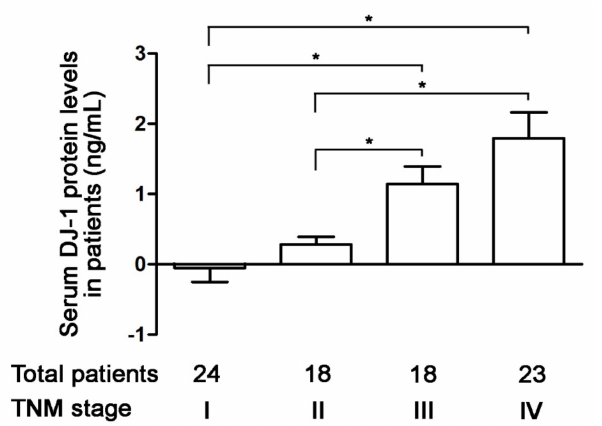
Figure 3. Increases in serum DJ-1 level are positively correlated with TNM stages of colorectal cancer in Taiwanese patients. The ELISA data show that serum DJ-1 levels in 24 patients with TNM stage I colorectal cancer were about zero. Serum DJ-1 protein levels in TNM stage II ( n = 18), III ( n = 18), and IV ( n = 23) colorectal cancer patients show TNM stage-dependently increase. It suggests that serum DJ-1 levels are positively correlated with the TNM stage of colorectal cancer in Taiwanese patients, which is consistent with our DJ-1 mRNA and DJ-1 protein expressions in tumor tissues. It indicates that DJ-1 is a colorectal cancer biomarker that increases in both tumor tissues and serum. Data are expressed as the means ± S.E.M, and the p -value was determined by one-way ANOVA/Newman-Keuls test. *: p < 0.05 compared with the respective